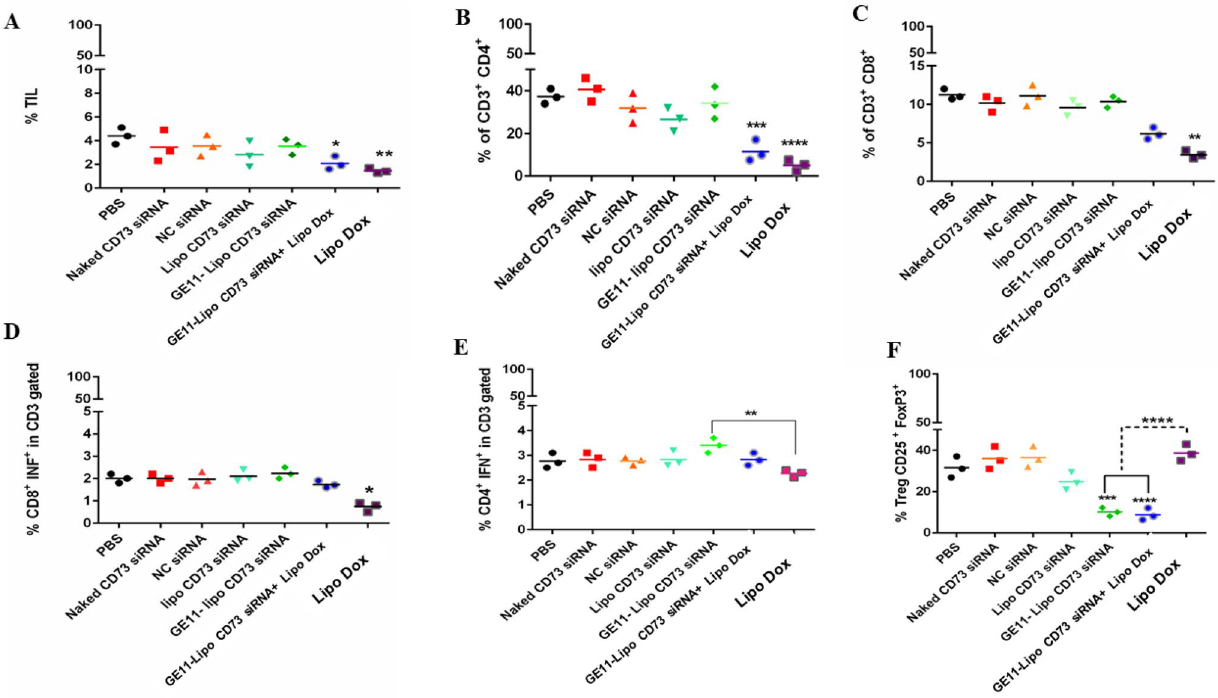
Figure 8. Frequency of tumor-infiltrated lymphocytes (TILs) and T cell subpopulations in the tumor environment of different groups. Two days after the last injection at the fourth week, three mice from each treatment group were sacrificed and cells from tumor tissue were isolated. Isolated cells were stained with conjugated antibodies against surface markers (CD3, CD4, CD8, and CD25 FoxP3). FACS analysis was carried out to determine the frequency of lymphocytes secreted into the tumor site. ( A ) The frequency of TIL following injection of mice with different formulations. ( B ) Liposomal formulation alone or in combination with GE11-Lipo CD73 siRNA decreased the frequency of CD3/CD4 positive lymphocytes. ( C ) Lipo Dox formulation group significantly decreased the frequency of CD3/CD8 positive lymphocytes ( P value < 0.01). ( D ) Lipo Dox formulation negatively affected the frequency of CD8 + , INF + lymphocytes. In combination group, the negative effect of Lipo Dox formulation is attenuated by GE11-Lipo CD73 siRNA formulation. ( E ) Frequency of CD4 + , INF + in CD3 gated lymphocytes. ( F ) Effect of different formulation on the frequency of Treg CD25 + , Foxp3 + lymphocytes. Data are reported as mean ± SD (n = 3). Statistically significant differences are represented as follows: * P < 0.05, ** P < 0.01, *** P < 0.001, **** P <